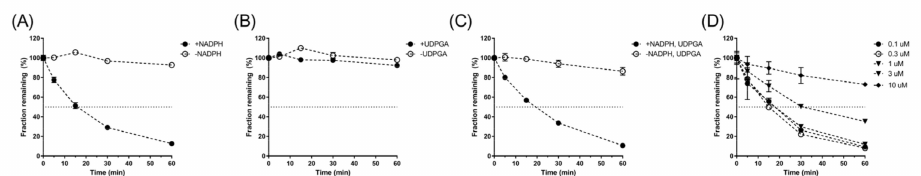
Figure 3. Metabolic stability of supinoxin in rat liver microsomes. Rat liver microsomes were incubated with 1 µ M supinoxin for 60 min in the presence and absence of ( A ) NADPH, ( B ) UDP- glucuronic acid (UDPGA), or ( C ) both NADPH and UDPGA as a cofactor. In addition, ( D ) metabolic stability of supinoxin in concentration ranges of 0.1–10 µ M was tested. Data are expressed as the mean ± standard deviation of triplicate runs.